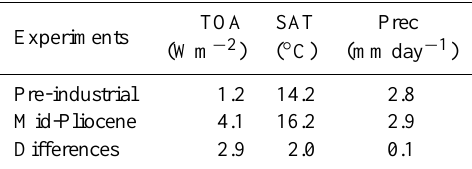
Table 2. Global annual mean of net energy at the top of atmosphere (TOA), surface air temperature (SAT) and precipitation rate (Prec) for the pre-industrial, mid-Pliocene, and the differences between mid-Pliocene and